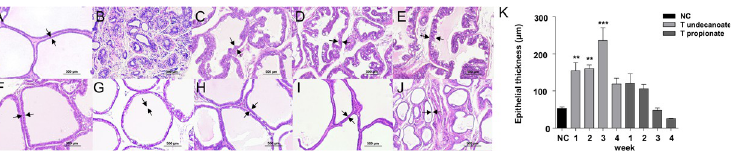
Fig 4. Histomorphological changes in the prostate tissue. Histomorphological changes in the prostate tissue. Castrated treatment groups were injected testosterone undecanoate (T undecanoate) or testosterone propionate (T propionate) at intervals of 1, 2, 3, or 4 weeks, all using the same concentration (125 mg/kg b.wt). Representative prostate tissue samples from each group were selected and stained with hematoxylin and eosin (H&E) and imaged at × 100 magnification. Microscopic images of the prostate samples (100 × magnification) are shown from the following groups: Normal control (NC) (A); Castrated control (CC) (B); 1-week interval of T undecanoate (C); 2-week interval of T undecanoate (D); 3-week interval of T undecanoate (E); 4-week interval of T undecanoate (F); 1-week interval of T propionate (G); 2-week interval of T propionate (H); 3-week interval of T propionate (I); 4-week interval of T propionate (J). Epithelial thickness values are expressed as the mean ± SD (K). � p < 0.05, �� p < 0.01, ��� p < 0.001 compared with normal control (NC). Statistical analysis was performed by ANOVA and Dunnett’s multiple comparison